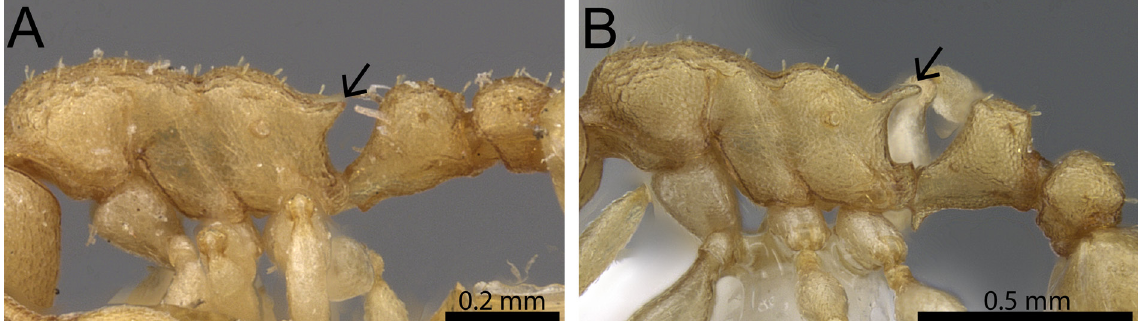
Fig. 12. Head, mesosoma, and waist segments in profile. A . Nesomyrmex denticulatus (Mayr, 1901) (CASENT0914923). B . N. innocens (Forel, 1913) (CASENT0906195).